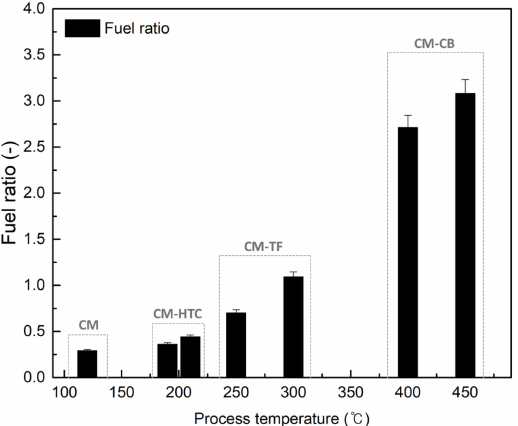
Figure 2. The fuel ratio of the cattle manure, hydrochar, torrefied char, and biochar.